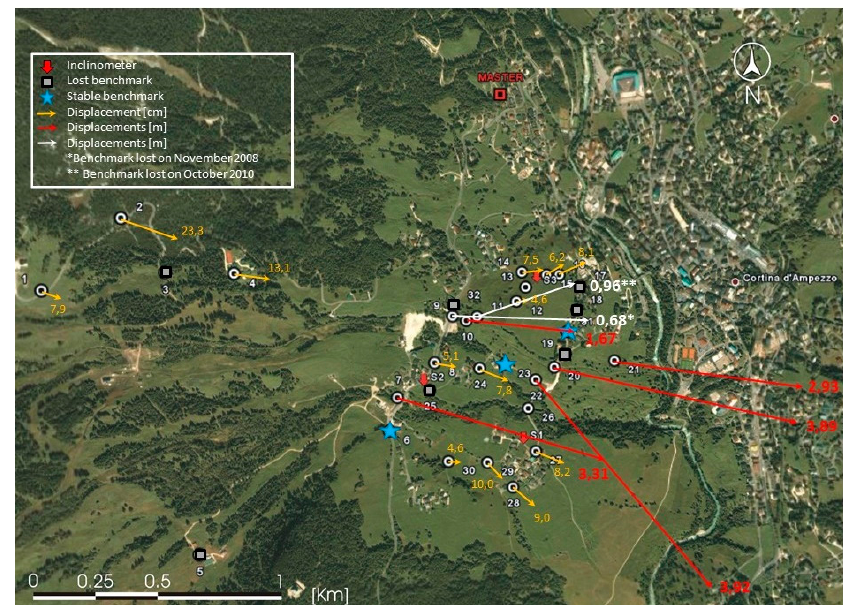
Figure 5. Horizontal displacements recorded with GNSS from July 2008 until April 2012.